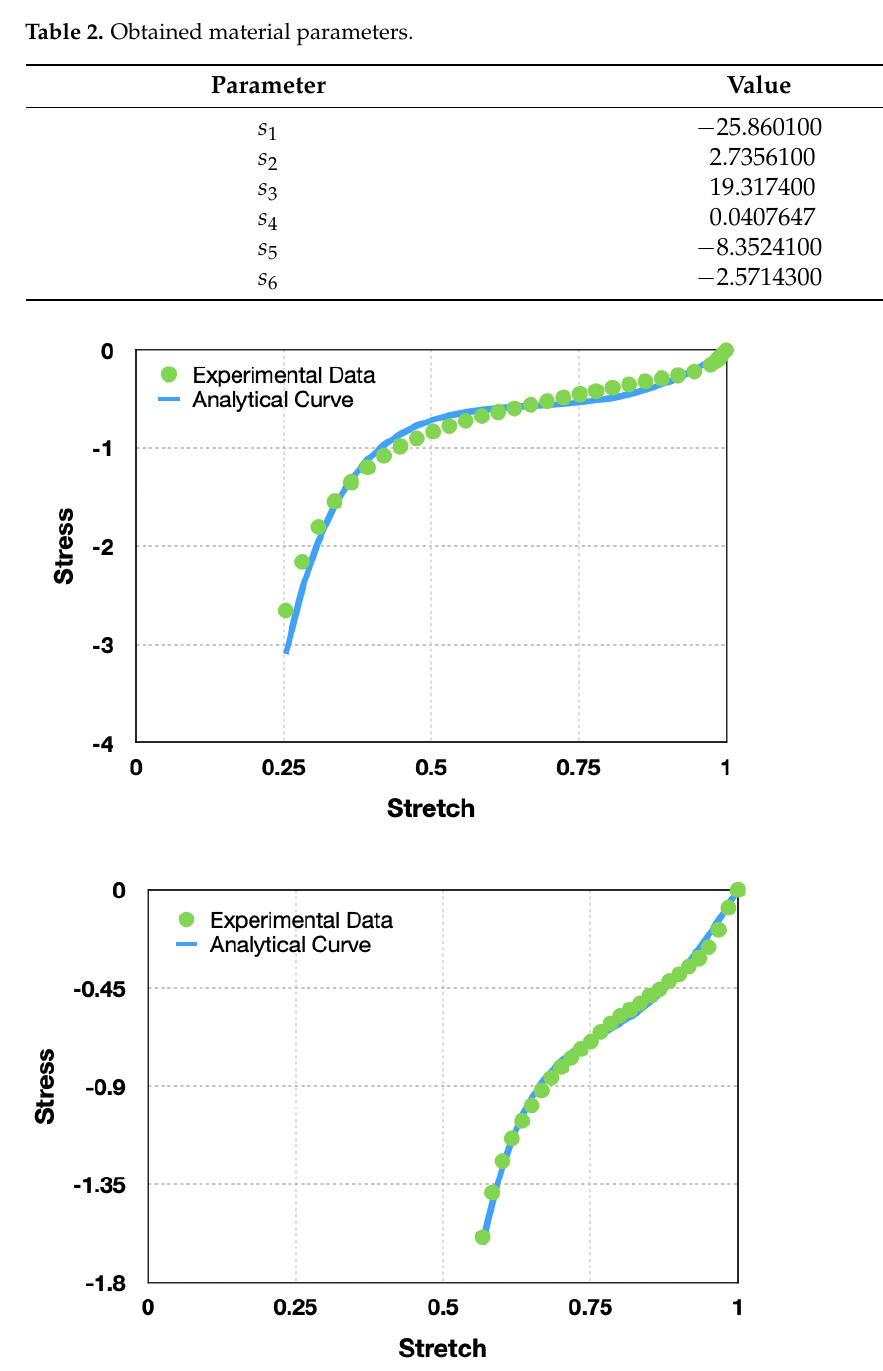
Figure 5. Comparison between analytical and experimental results for uniaxial and equibiaxial tests,